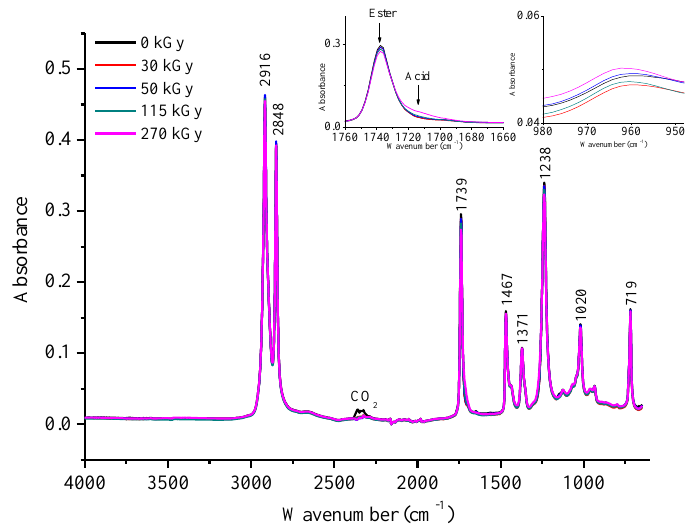
Figure 8. Overlay of EVA spectra for non-sterilized and γ-irradiated samples. Inset: enlargements of the carbonyl zone ( left ) and of the trans alkene zone ( right ). Reproduced from [28] with the permission of Polymer Degradation and Stability.